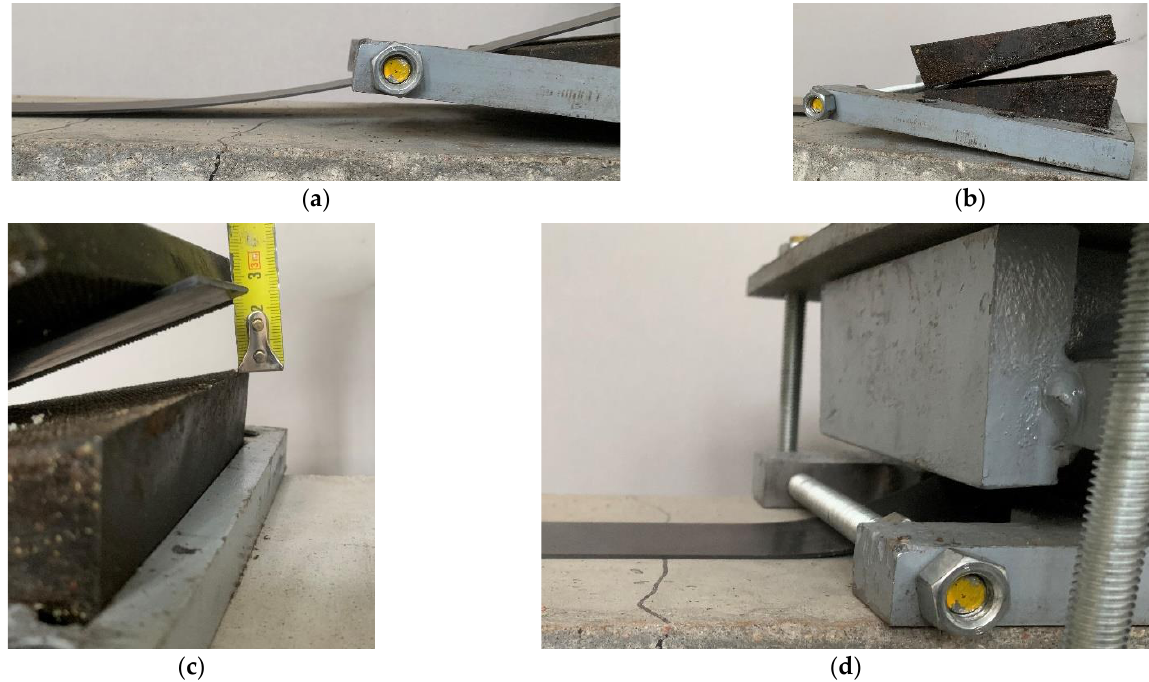
Figure 4. Bending of the CFRP laminate with clamping unit: ( a ) side view front, ( b ) side view back, ( c ) deflection, and ( d ) laminate pressed to concrete.